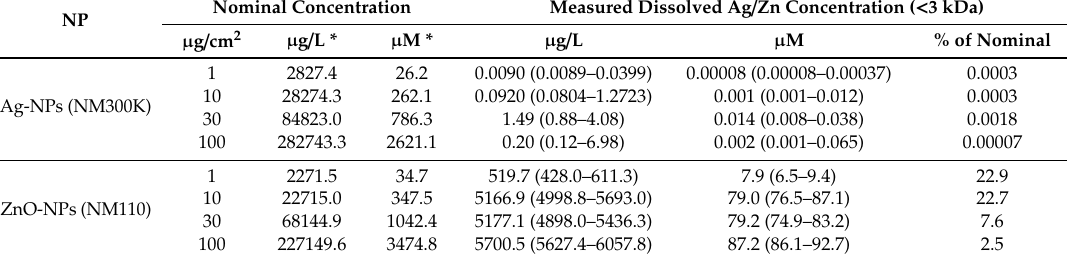
Table 4. Concentrations of dissolved Ag and Zn in dispersions of Ag- and ZnO-nanoparticles (NPs) in cell culture medium. Zn concentrations in medium without NPs was 25.7 µ g / L (25.4–150.9 µ g / L) or 0.4 µ M (0.2–2.3 µ M). Ag content was below the limit of detection ( < 0.006 µ g / L). Numbers are given as